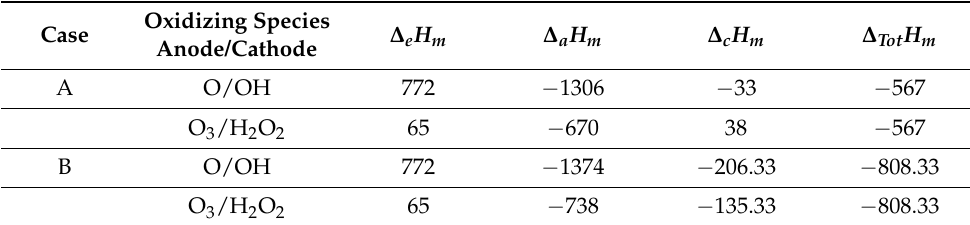
Table 2. Summary of energy balance calculations for Case A (see Section 2) and Case B (see Section 3). The units for the electrolysis heat, ∆ e H m ; anodic heat of combustion, ∆ a H m ; and cathodic heat of combustion, respectively, are kJ/mol